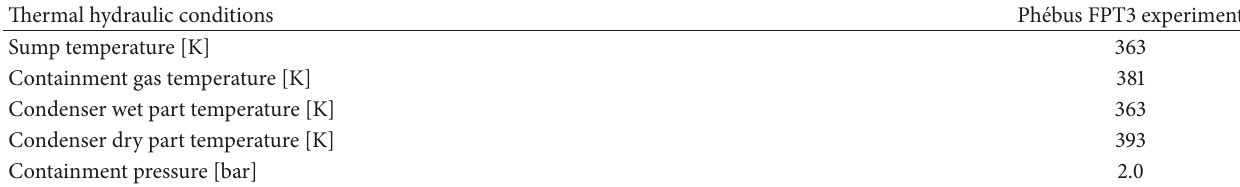
Table 4: Thermal hydraulic conditions of the aerosol phase [25].